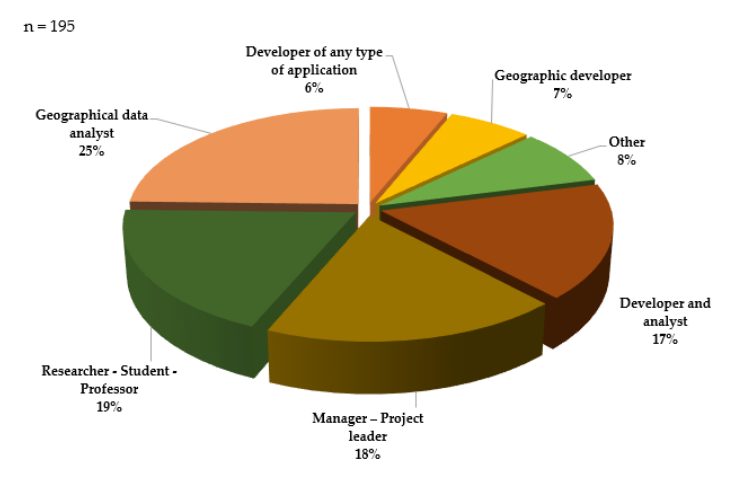
Figure 3. Employment role of